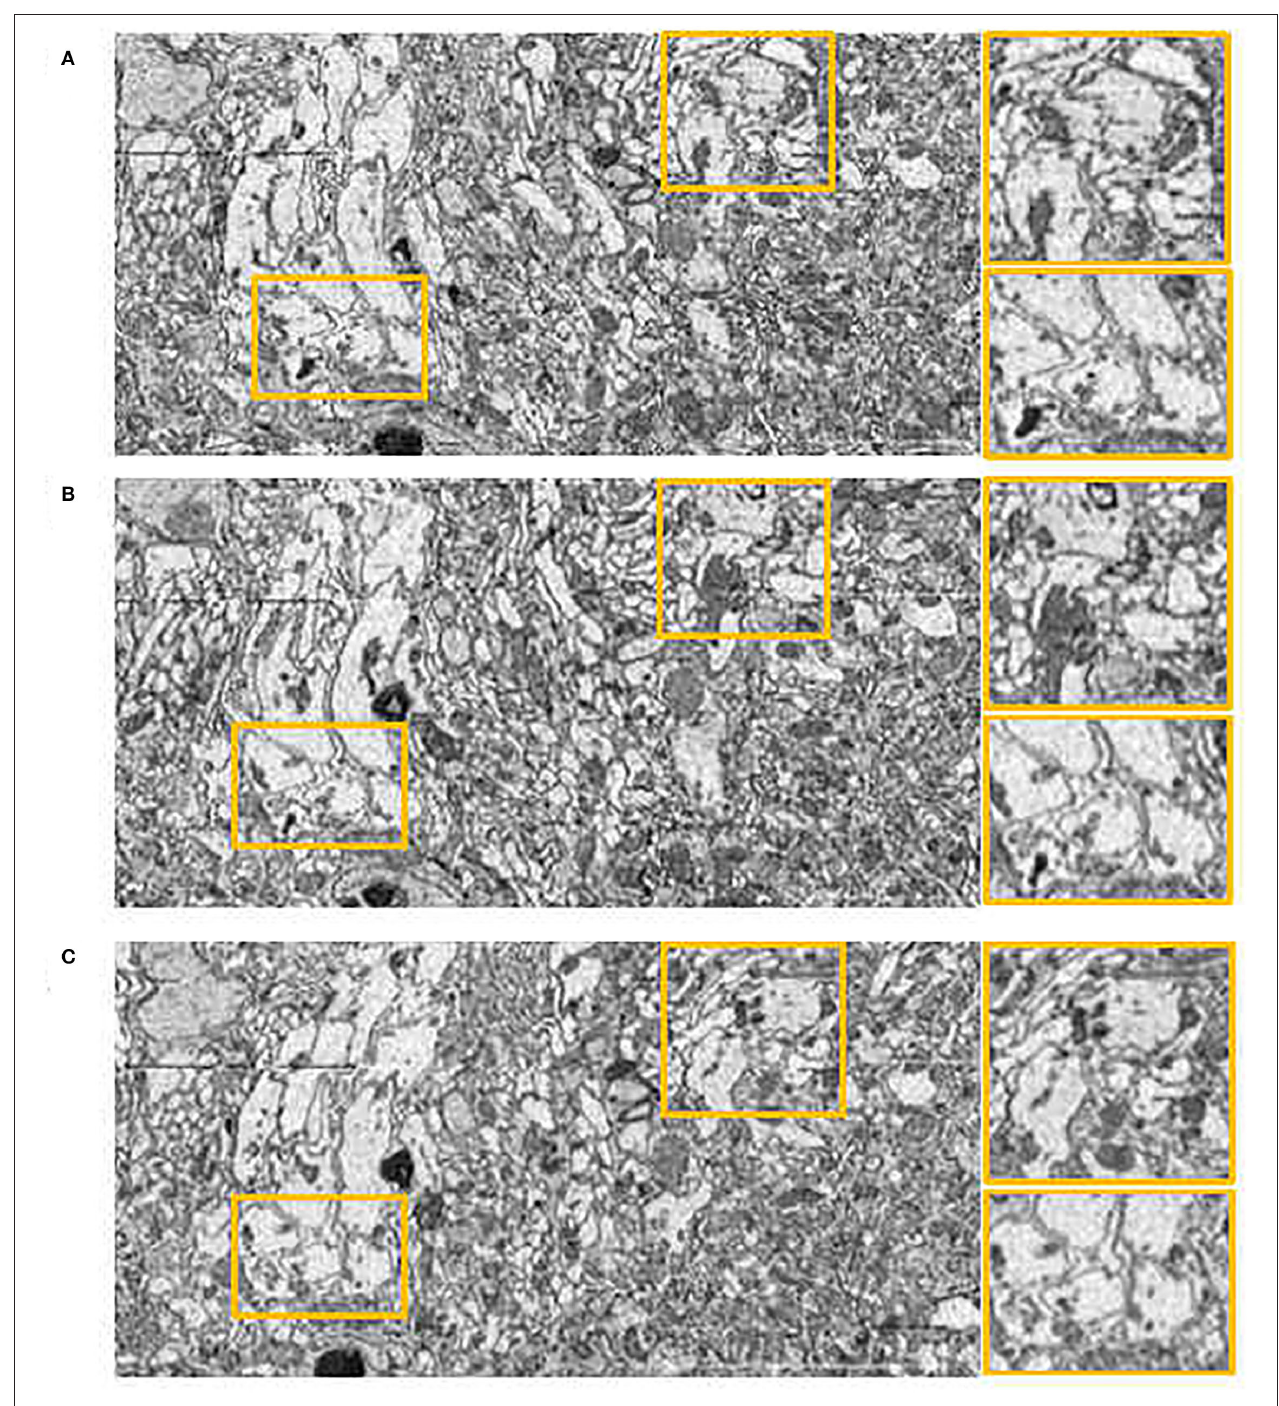
FIGURE 8 | Registration results in yz plane on the Drosophila ssTEM (DST) dataset. (A) Wang CW results. (B) Elastic results. (C) Our results.